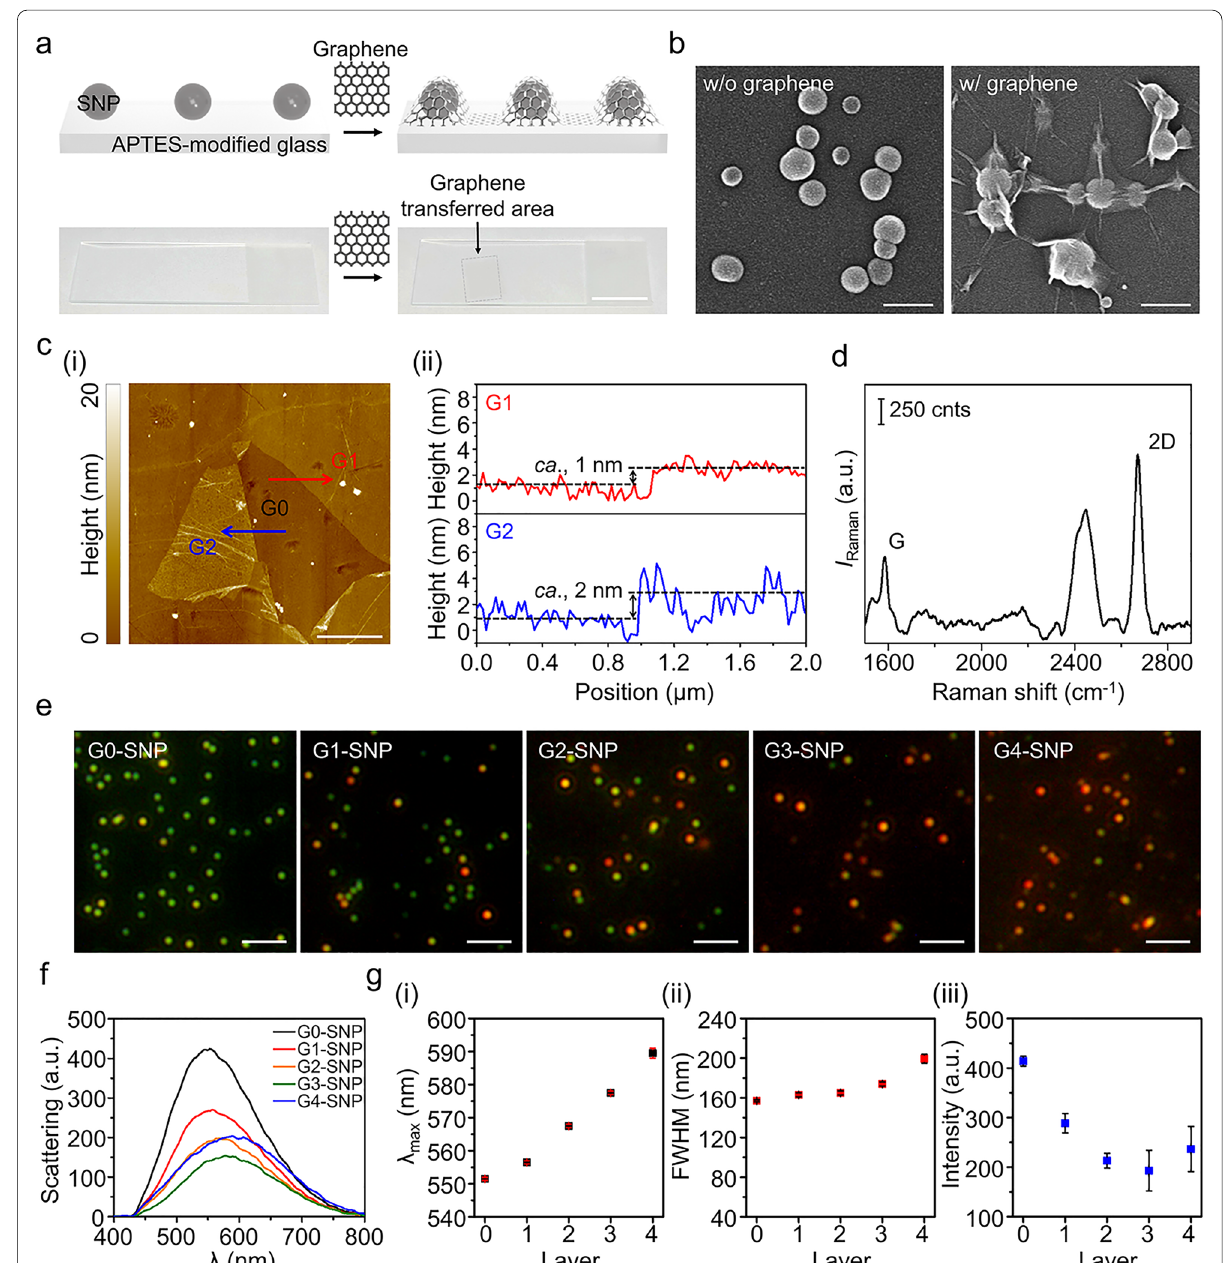
Fig. 3 Characteristics of the graphene-covered plasmonic NPs and their optical properties. a Graphene transfer process to the NP immobilized on the APTES-modified glass substrate (upper) and photographs of substrates before and after transferring a graphene layer (lower). Scale bars represent 2 cm. b Scanning electron micrographs of the SNPs (left) and the graphene-covered SNPs (right). Scale bars represent 200 nm. c Topographic images (i) and height profiles (ii) of the graphene layers transferred on the glass substrate. Scale bar represents 2 μm. Height profiles correspond to the lines denoted as G1 and G2. d Raman spectra of the graphene-covered SNP substrate. e Dark-field scattering images of the graphene-covered plasmonic SNPs with increasing number of graphene layers. The scale bars represent 10 μm. f Corresponding scattering spectra measured for the SNPs with increasing number of graphene layers. g Plots for the shifts in terms of λ max (i), FWHM (ii), and intensity (iii) with increasing number of graphene layers on the